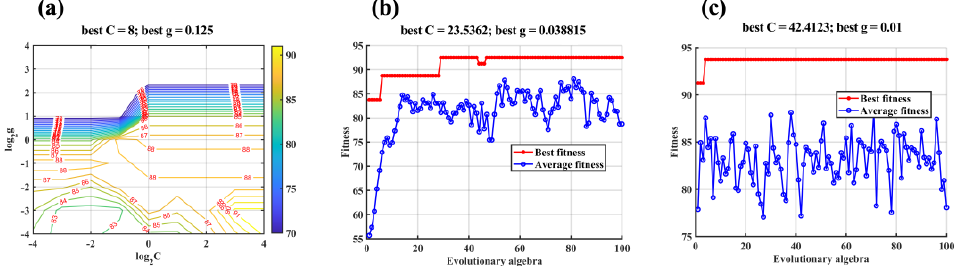
Figure 9. Parameter selection results of ( a ) GS−SVC , ( b ) GA−SVC , and ( c ) PSO−SVC .